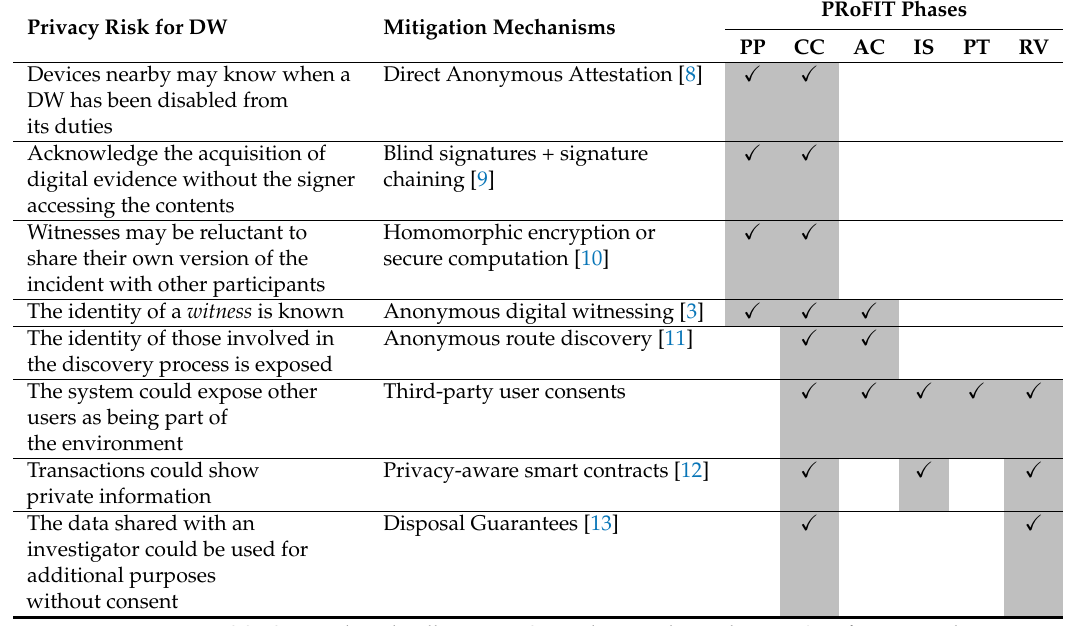
Table 2. Mapping of privacy risks and mitigation mechanisms in a PRoFIT-compliant